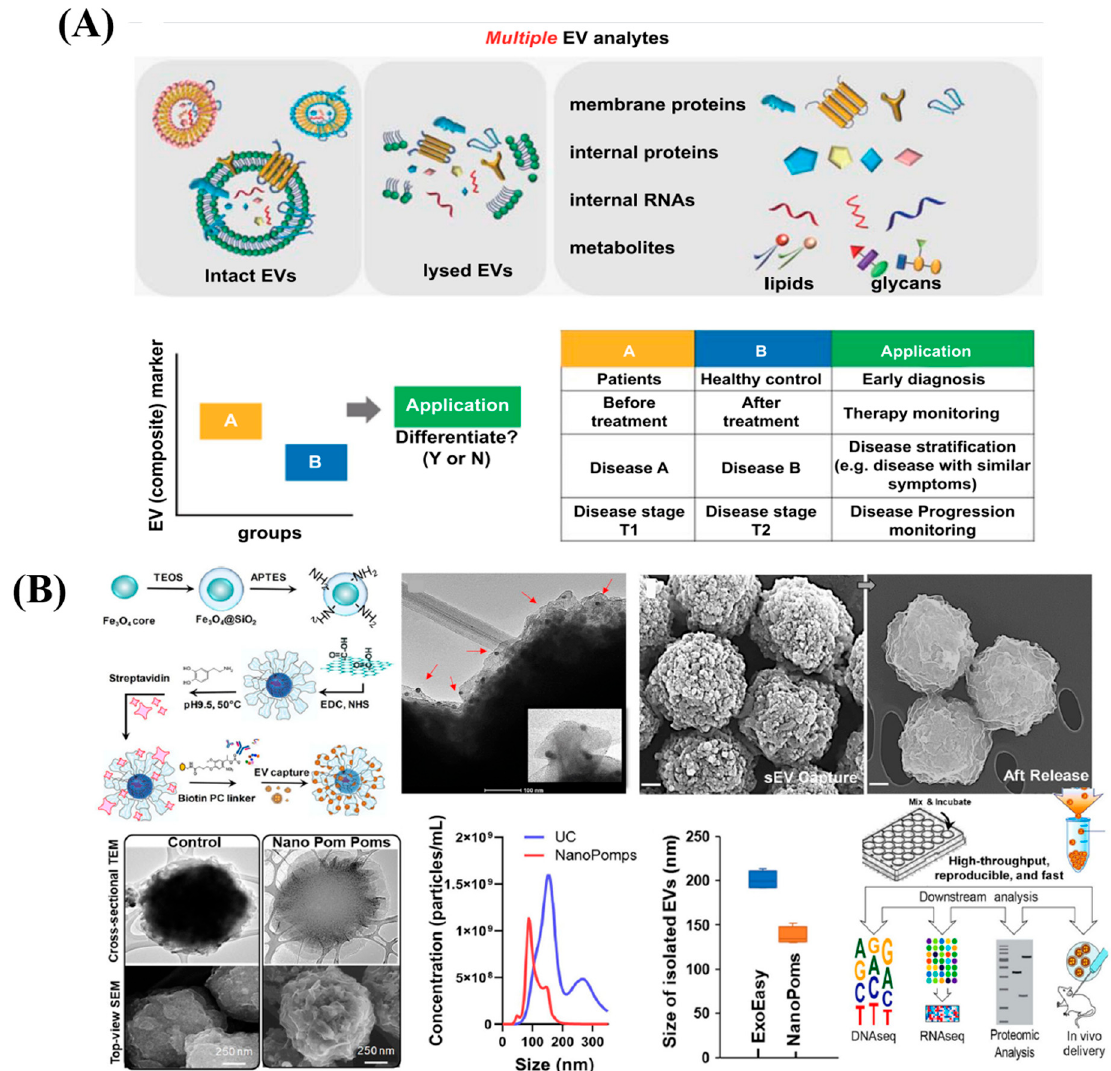
Figure 9. ( A ) Pictorial image of potential clinical applications of composite EV biomarkers. Re-used with permission from Ref. [83] and ( B ) represents the Nano pompoms fabrication for highly specific exosome isolation and multi-omic biomarker analysis. Re-used with permission from Ref. [84].